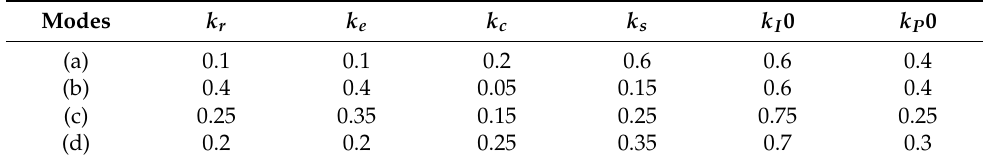
Table A1. Parameter settings.